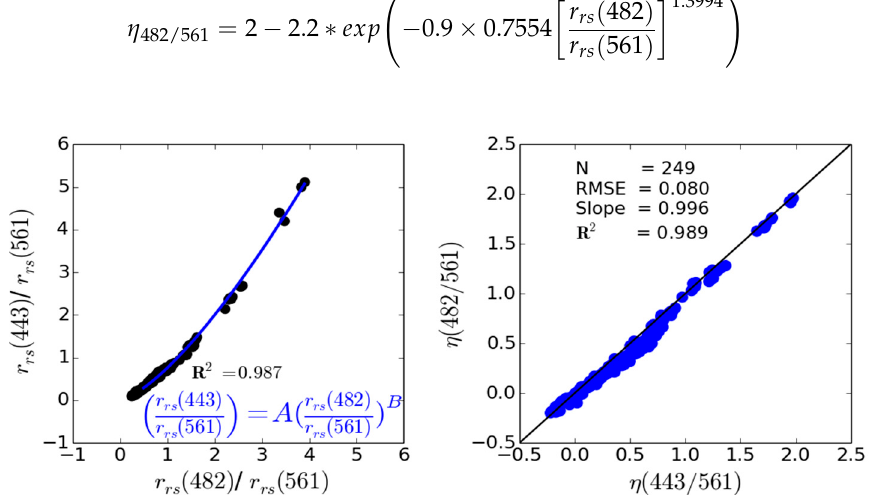
Figure 2. The strong relationship ( left ) between the band ratios of subsurface remote sensing reflectance in the blue and green channels, i.e., r rs (482/561) and r rs (443/561). The relationship follows the power-law function (A = 0.7554, B = 1.3994) and provides a high correlation coefficient, i.e., R 2 = 0.987. The scatterplot ( right ) shows the cross-validation of η derived using two different band ratios, i.e., r rs (443 /561) and r rs (482/561). Table 1. The OLI, ETM+ and TM spectral band centers (nm) computed in SeaDAS.